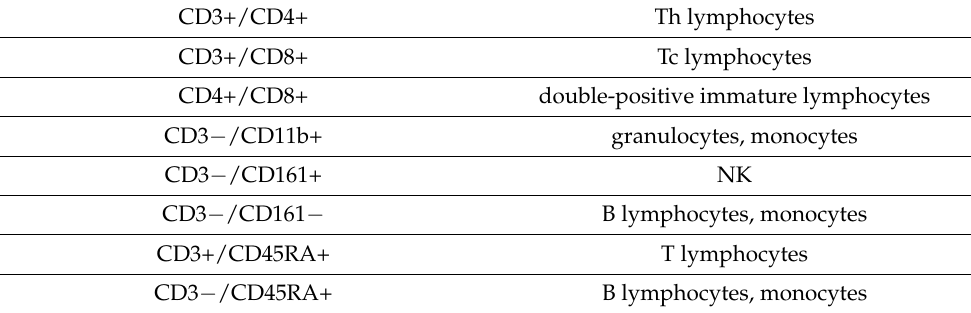
Table 2. Lymphocyte